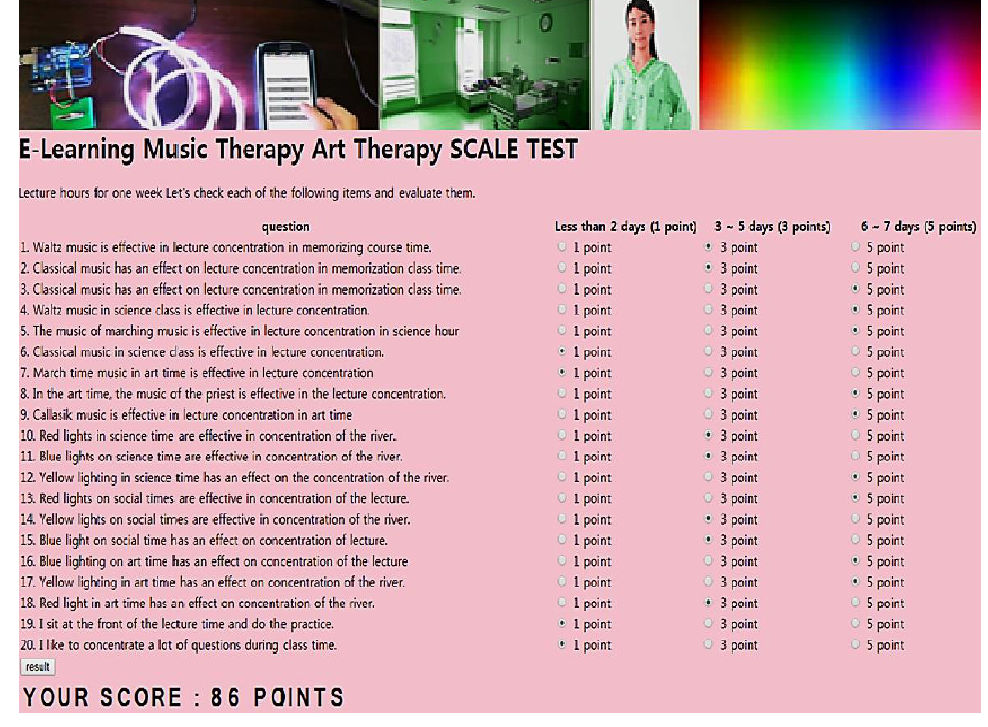
Figure 3. Art therapy scale test.